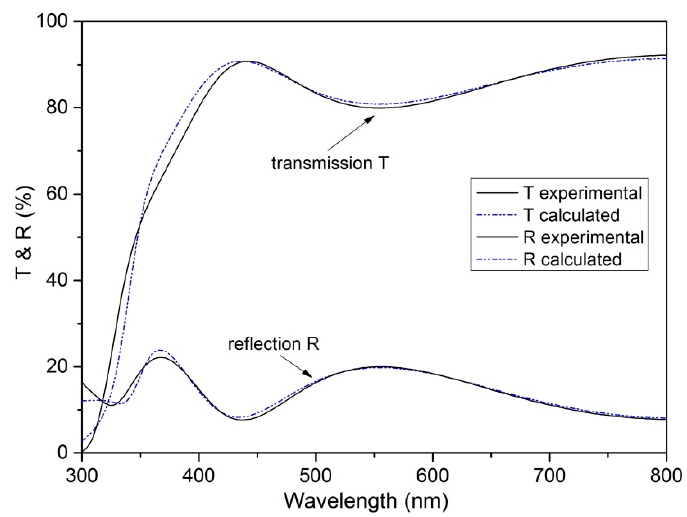
Figure 9. Transmission and reflection spectra vs. wavelength for sample AZO-4 (Al content 7.9%); experimental and calculated data (on the basis of Cauchy model).